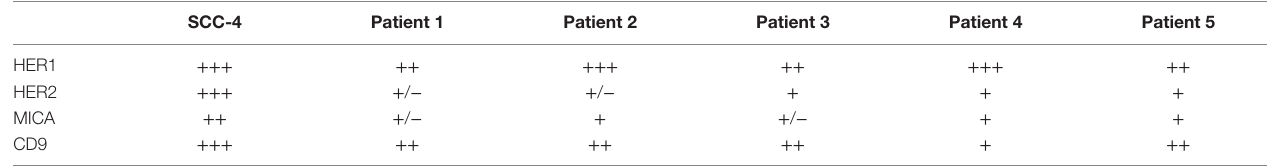
TaBle 2 | antigen expression levels measured on singularized patient hnscc cells ( n = 5) after preparation from tumors.